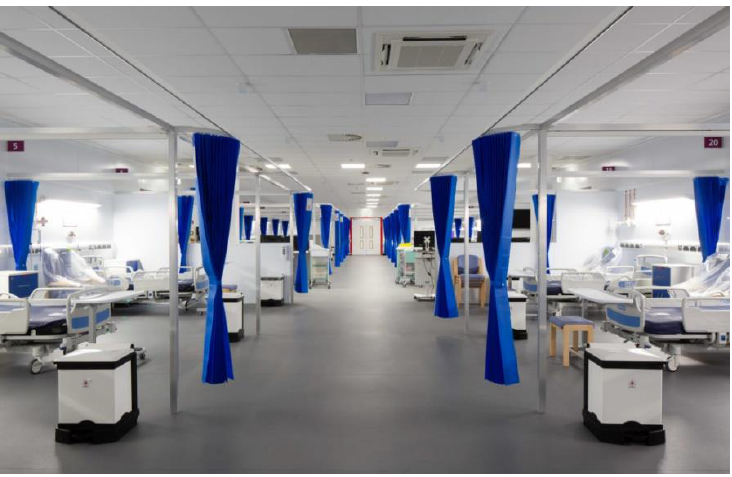
Figure 3. UK Nightingale Hospital Exeter © Stride Treglown / Tom Bright [87].